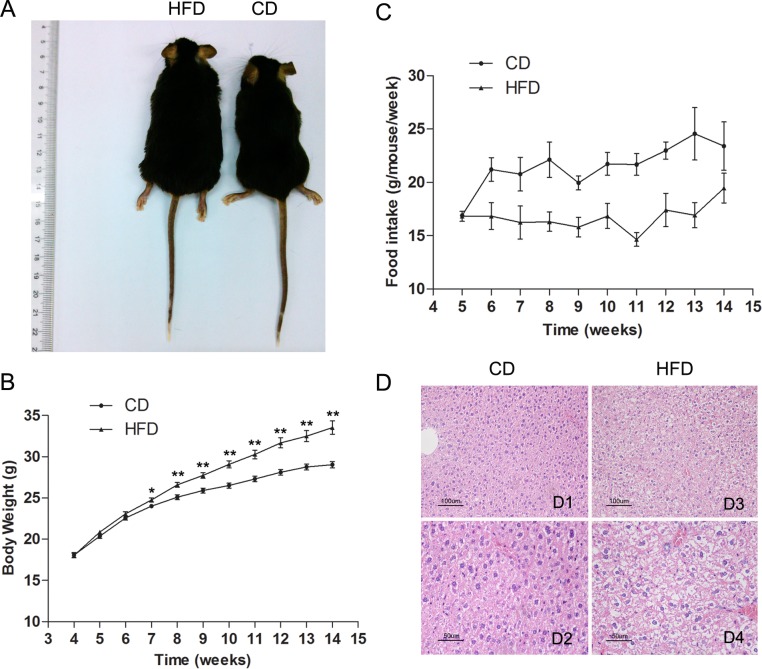
Description of an obese mouse model established after 10 weeks on HFD.(A) Representative picture of 15-week old obese and control mice. (B) Comparison of time-dependent increases in body weight between CD (n = 27) and HFD groups (n = 30). (C) Weekly food consumption by mice in CD and HFD groups. (D) Hematoxylin and eosin-stained hepatic sections from mice both fed control diet (CD) and high-fat diet (HFD). (D2) and (D4) are two-fold enlarged views of (D1) and (D3). Scale bars = 50 μm. Data are expressed as mean ± SEM. * P<0.05, ** P<0.01.